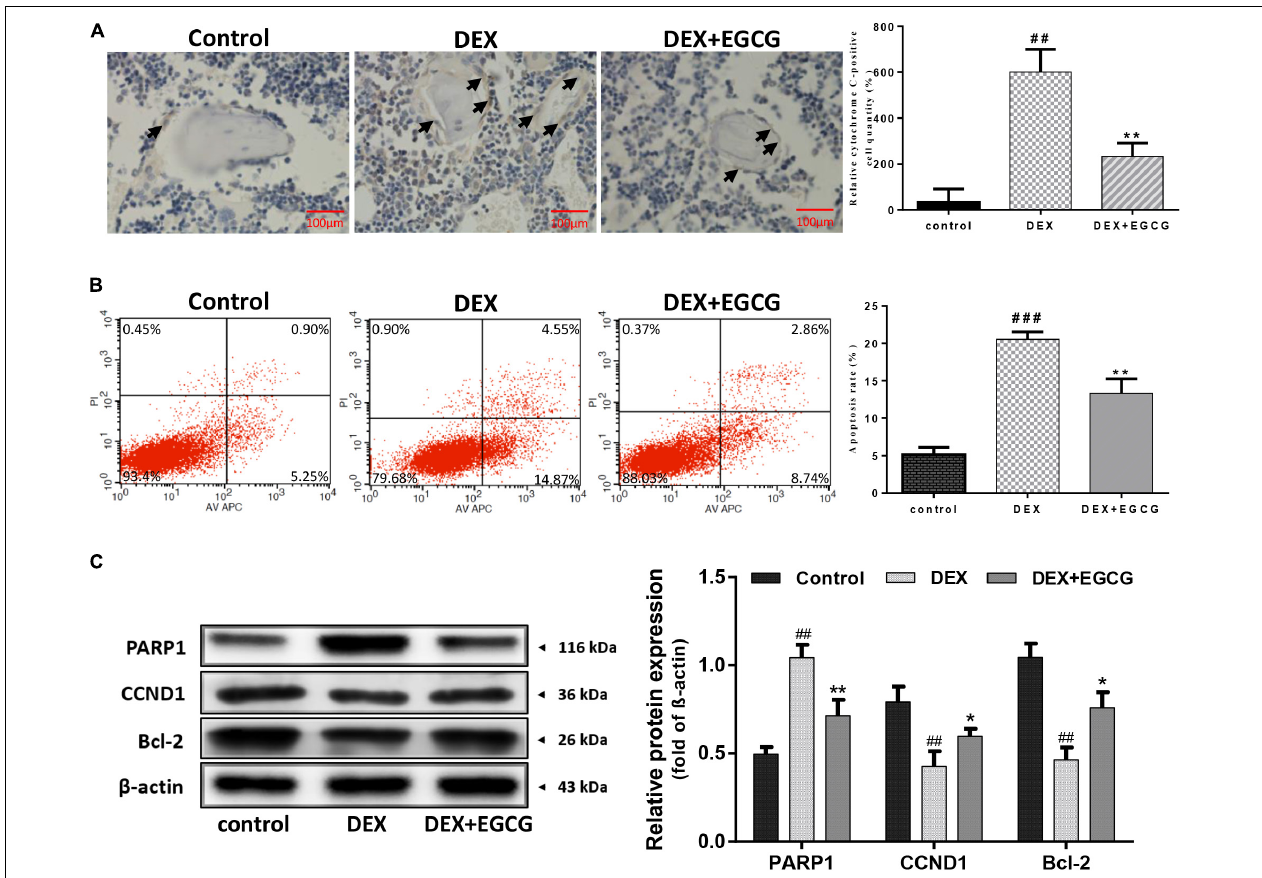
FIGURE 2 | Protective effect of EGCG against DEX-induced apoptosis in GIO. (A) Cell apoptosis was measured by immunohistochemistry (arrow indicates cytochrome C positive cells) and was statistically evaluated. (B) Flow cytometric analysis was used to measure apoptotic rate, and the level of apoptotic rate was statistically evaluated, as shown in the column. (C) Expression of apoptosis-related protein was measured by Western blot, and quantitated levels of protein were statistically evaluated, as shown in the column. The data were expressed as the mean ± SD . ### P < 0.001, ## P < 0.01, # P < 0.05 vs. control and ∗∗ P < 0.01, ∗ P < 0.05 vs.